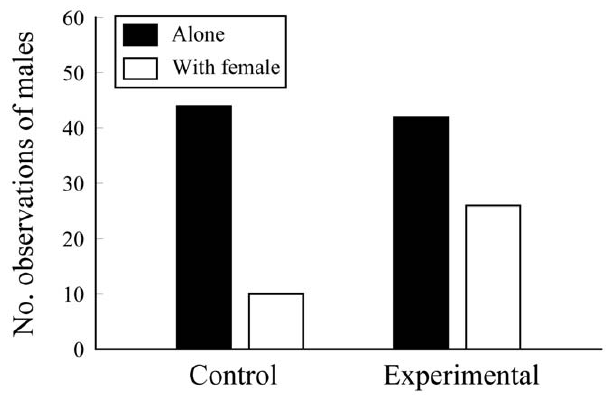
Figure 2. Association of females with males. Observations of adult male lizards that were alone (black bars) or close (less than 50 cm) to one or several adult females (open bars) in the control and experimental